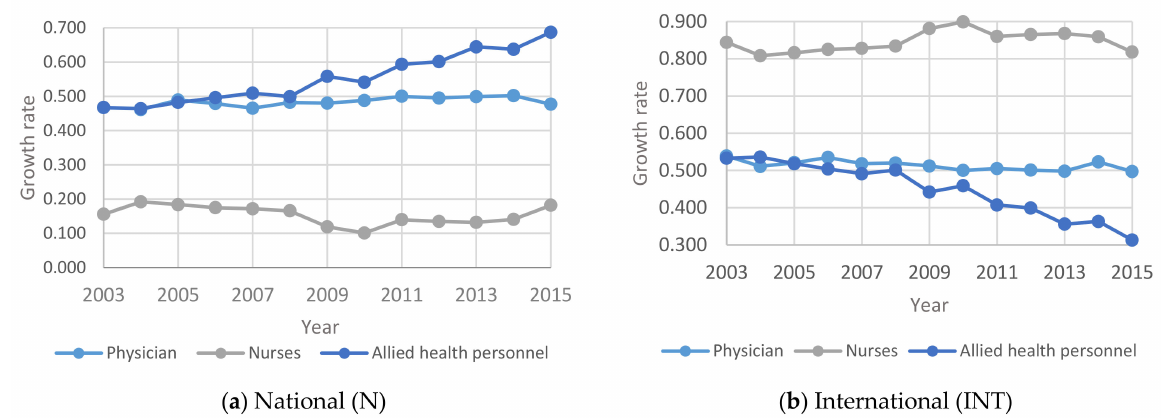
Figure 4. Annual Percentage changes for HHR in the OGH sector between 2003 and 2015: ( a ) National (N); ( b ) Interna- tional